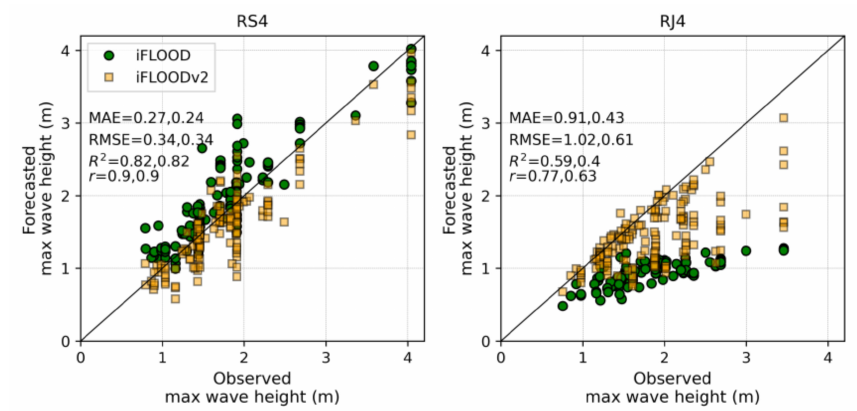
Figure 6. Scatter plots of the predicted maximum significant wave heights vs. observed waves during daily weather conditions from 26 April to 31 August